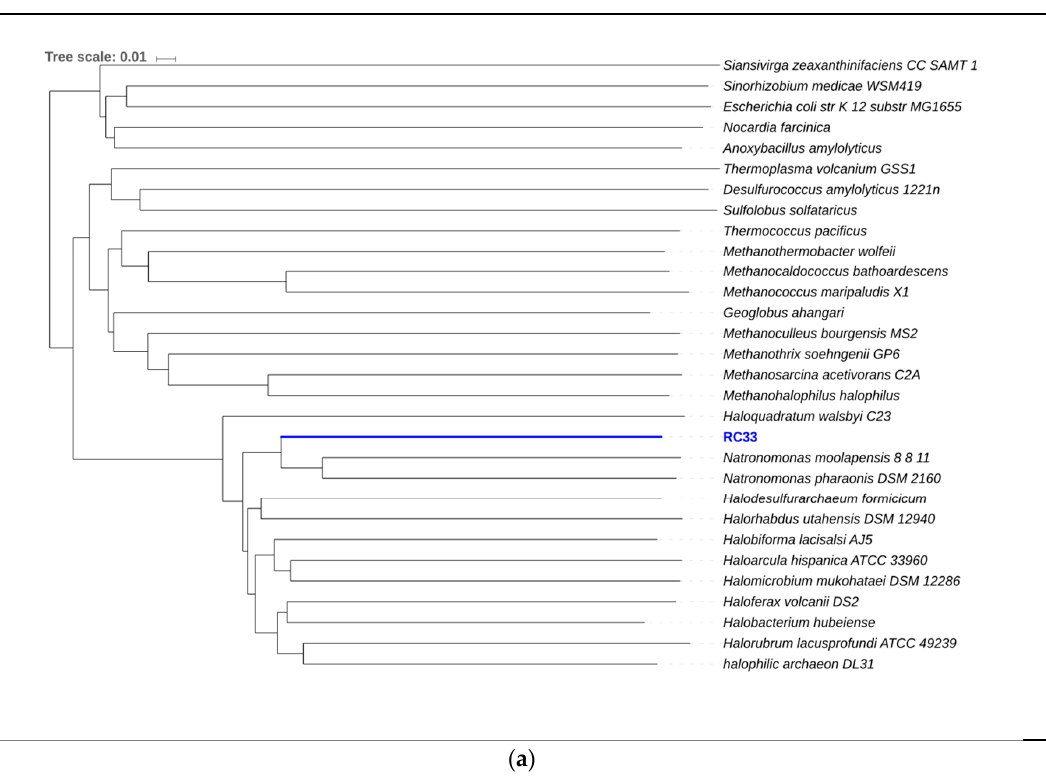
Table 4. Amino acid identity (AAI) of the four genomic bins obtained. The closest relative of each organism, along with its AAI and fraction of proteins shared, are listed. Bin